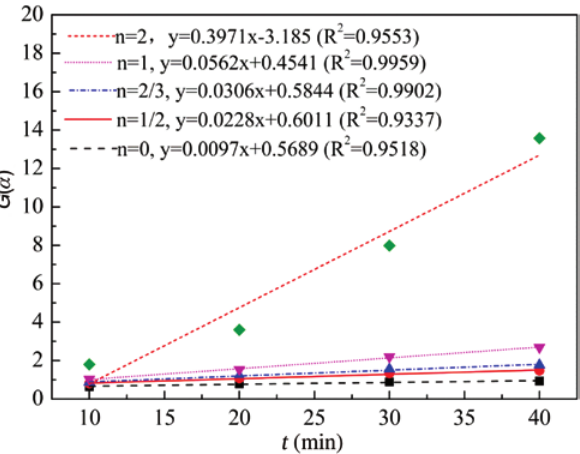
Figure 11: The relationship between G ( α ) and time at 600 ° C on n = 0, 1/2, 2/3, 1, 2,